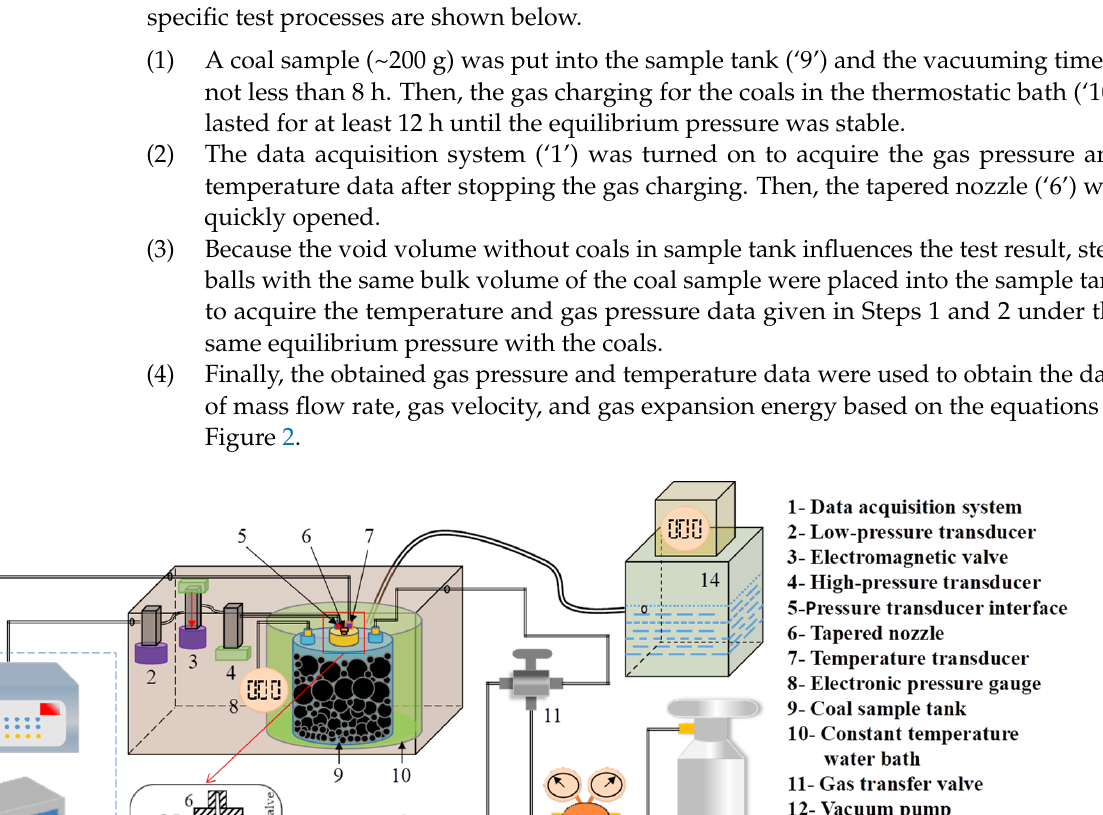
Figure 1. Schematic diagram of the test device.